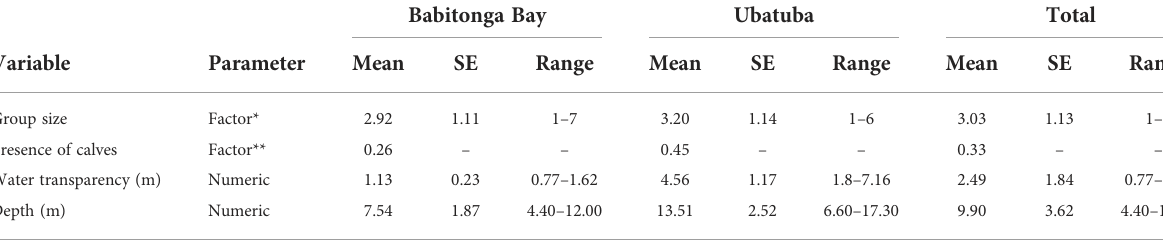
TABLE 7 Summary of biological and environmental variables recorded in Babitonga Bay and Ubatuba and tested in the generalized mixed- effects